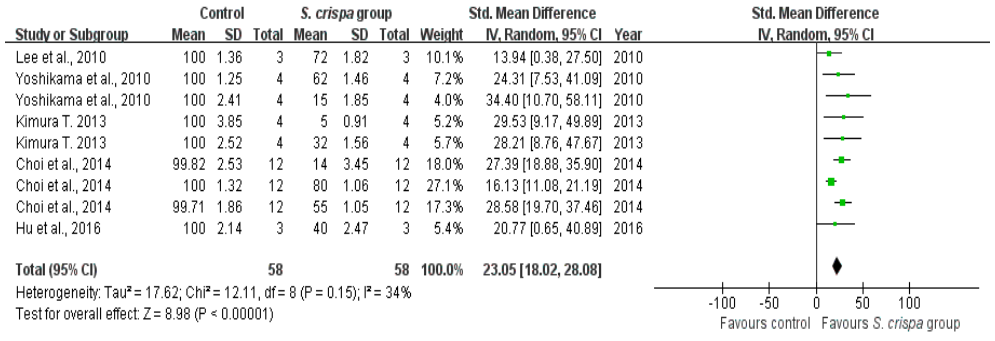
Figure 4. Comparison of the survival of cancer cells between control and S. crispa groups. ( ): SMD of individual studies; ( ): summary SMDs of the comparison.